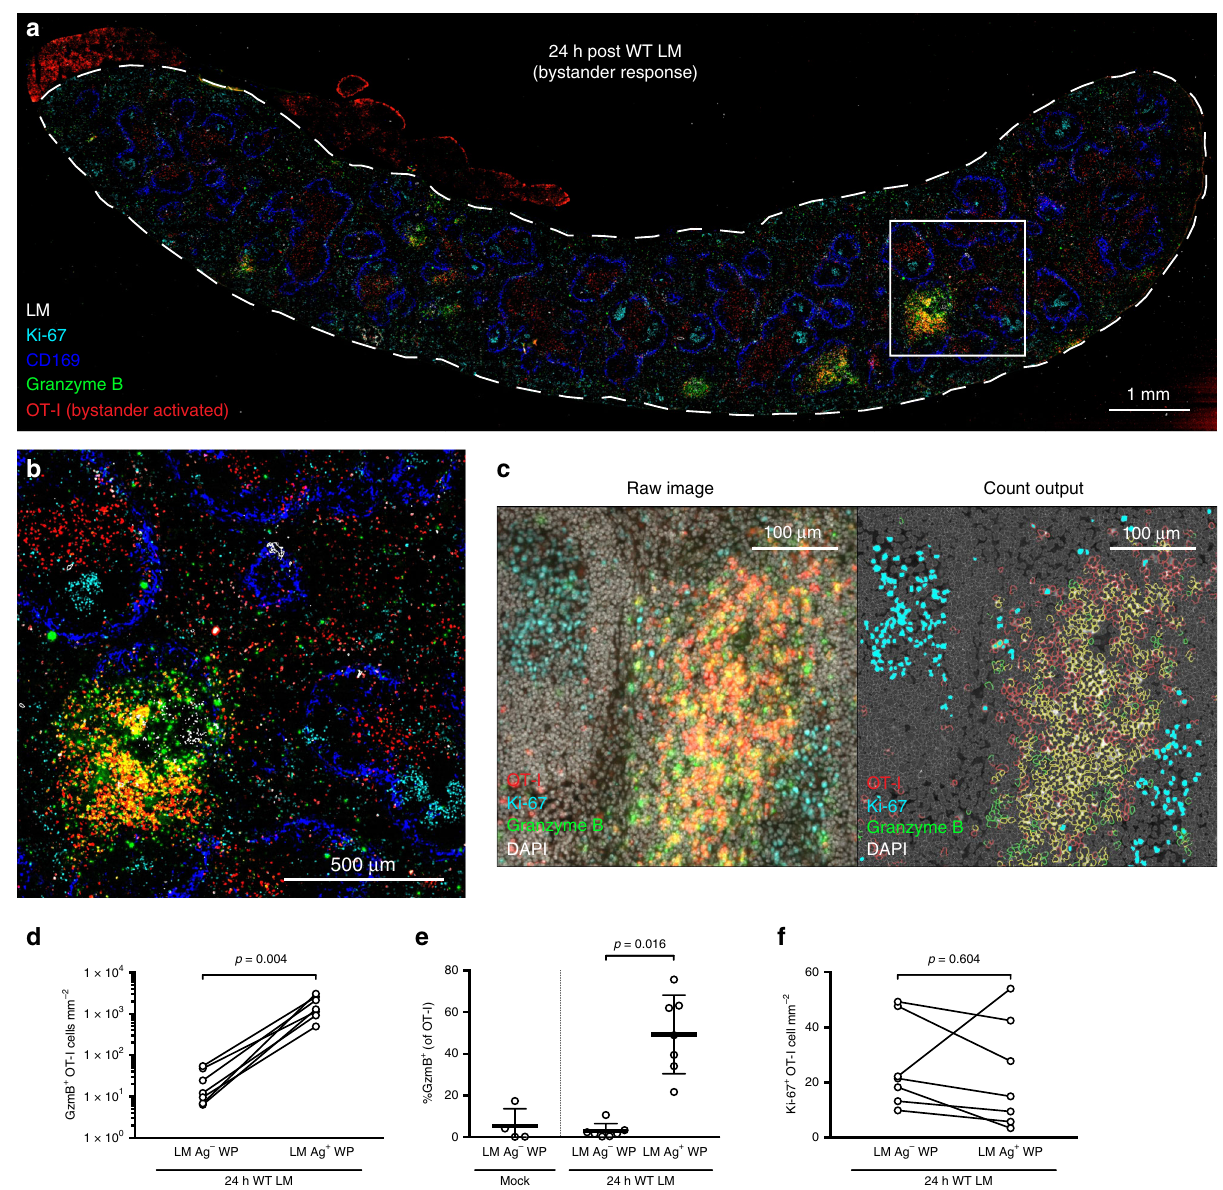
Fig. 2 Bystander-activated OT-I T cells form clusters without proliferating. a , b Representative image of spleen 24 h post WT LM immunization from serially sectioned 8 µ m slides stained for LM (white), CD169 + MMM (blue), OT-I (red), granzyme B (green), and Ki-67 (cyan). c Raw IF images showing OT-I (red), Ki-67 (cyan), granzyme B (green), and DAPI (gray), and cell identity outputs used for cell enumeration (OT-I, red; granzyme B, green; OT-I and granzyme B co-staining, yellow; Ki-67 + nuclei, cyan; Ki-67 − nuclei, gray) from HALO digital pathology software. d – f Enumeration of cell densities and frequencies from HALO-analyzed IF images. d Density of granzyme B + OT-I cells amongst splenic WP stained for the absence (LM Ag – ) or presence (LM Ag + ) of WT LM 24 h after immunization. e Frequency of granzyme B expression in OT-I T cells within WP from unimmunized animals (Mock) and WP from animals 24 h post WT LM immunization (24 h WT LM), strati fi ed by presence of LM Ag (LM Ag – , LM Ag + ). f Density of Ki-67 + OT-I T cells amongst splenic WP absent or containing LM Ag 24 h after WT LM immunization. In a , b image is representative of n = 7 spleens. Contrast was increased and tissue orientation was modi fi ed in Adobe Photoshop to overlay serially sectioned slides. LM Ag staining was outlined to increase visibility using “ fi nd edges ” in ImageJ; after, all channels were merged using ImageJ. In d – f each symbol (mock immunization) or connected symbol pair (24 h post WT LM immunization) represents one animal from three experiments ( n = 4 mock-immunized, n = 7 WT LM-immunized). Indicated are statistical signi fi cances by Wilcoxon matched-pairs signed rank test. See also Supplementary Fig. 3. Source data are provided as a Source Data fi